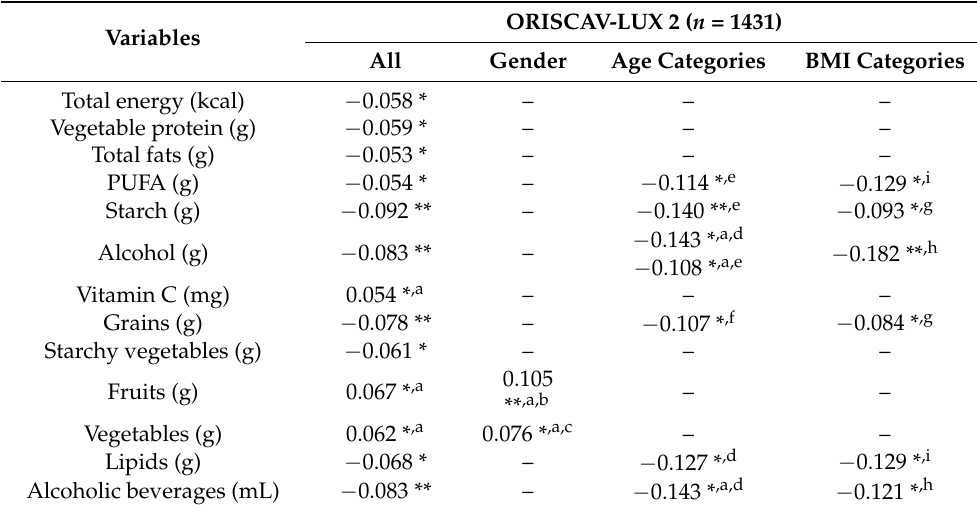
Table 5. Pearson coefficients of simple correlation between dietary factors and constipation score in age, gender, and BMI groups.